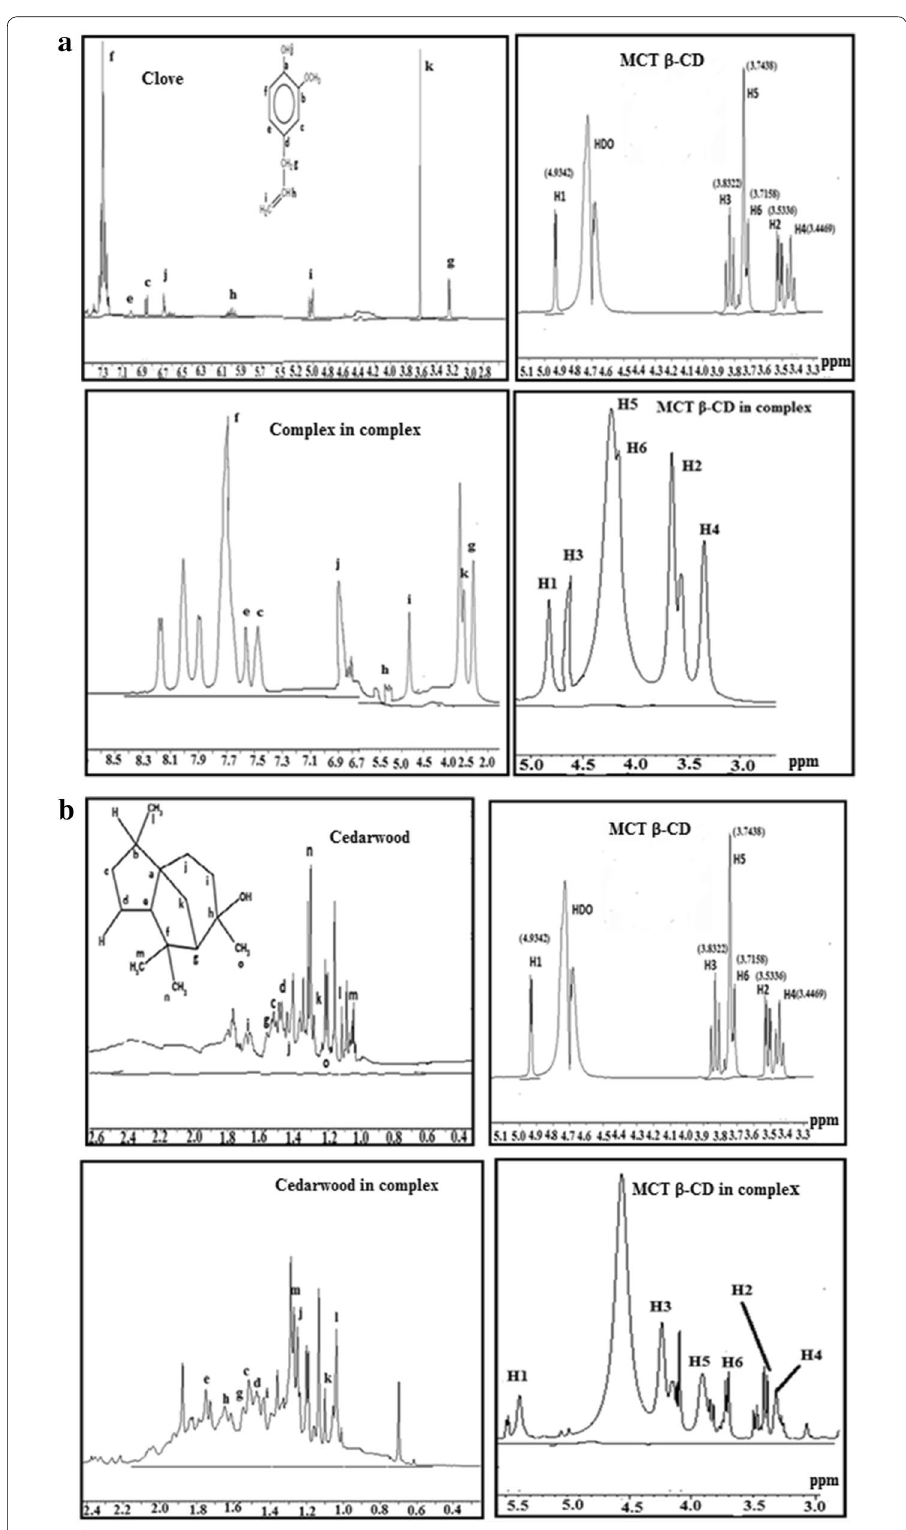
Fig. 9 1 H-NMR spectral analysis of MCT β-CD in free and complex state with essential oils in free and com- plex states. a Clove b